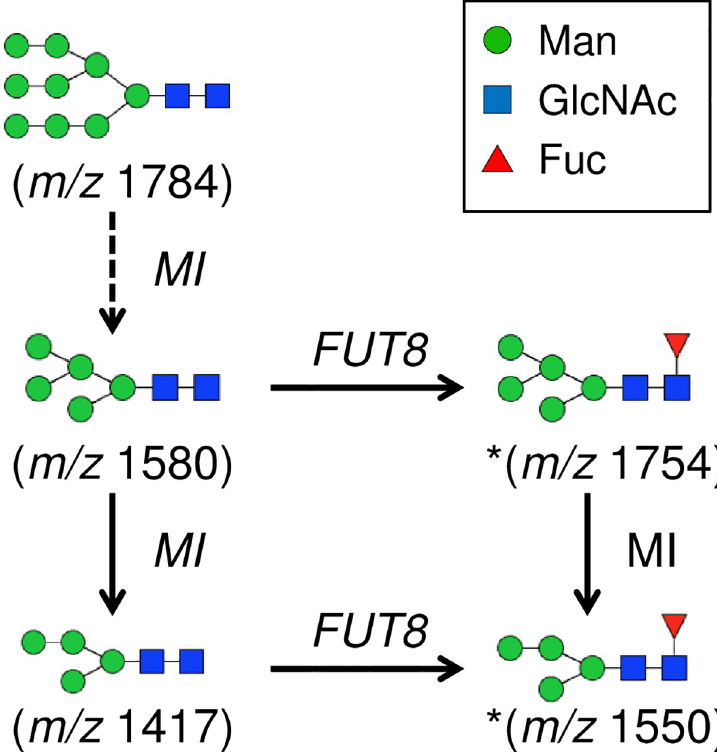
Fig 3. Possible biosynthetic pathways of high-mannose type N -glycans with the fucosylated core. FUT8, α 1,6-fucosyltransferase; MI, α -mannosidase I.